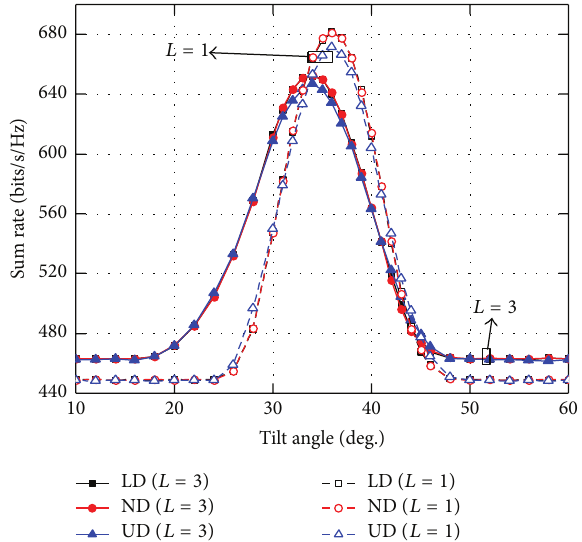
Figure 7: Simulated sum rate against the tilt angle for three user distributions ( 𝑝 𝑢 = 5 dB, 𝑁 𝑟 = 100 , 𝑁 𝑡 = 1 , 𝐿 = 1,3 , 𝐾 = 42 , 𝐷 = 200 m, 𝑅 = 100 m, 𝜐 = 4 , UD: uniform distribution, ND: normal distribution, and LD: linear distribution).